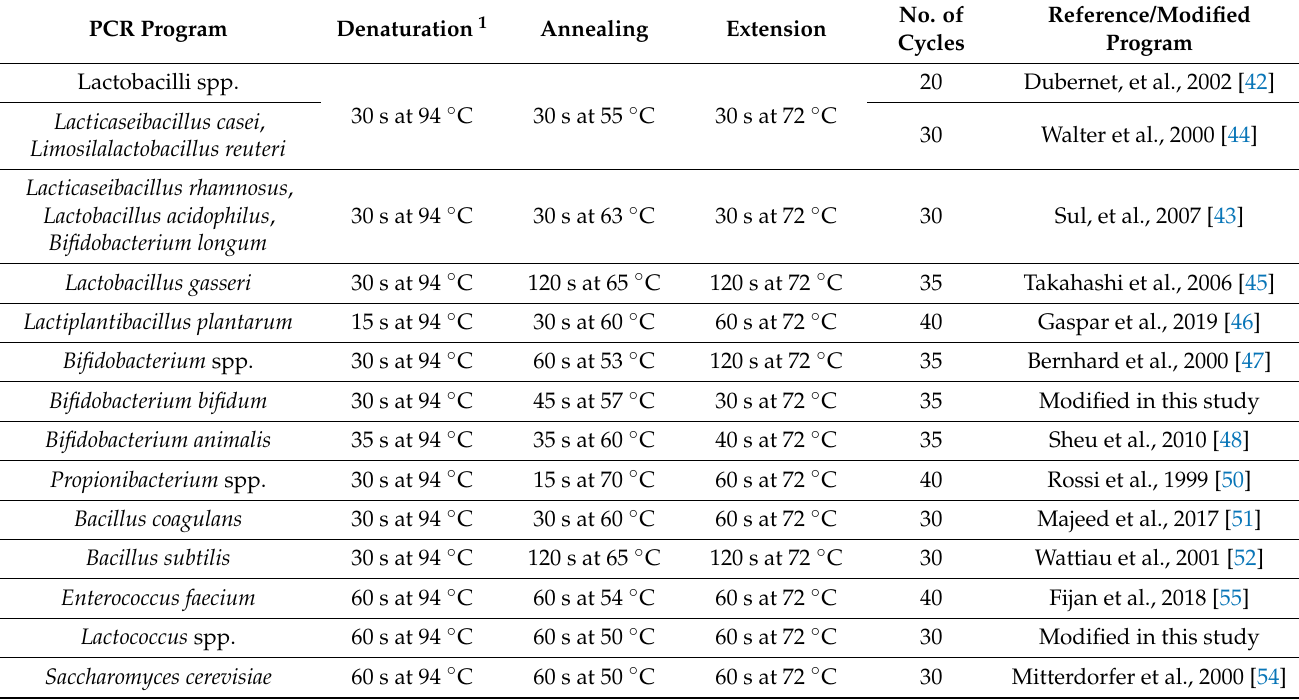
Table 5. Cycling parameters for polymerase chain reaction programs of selected